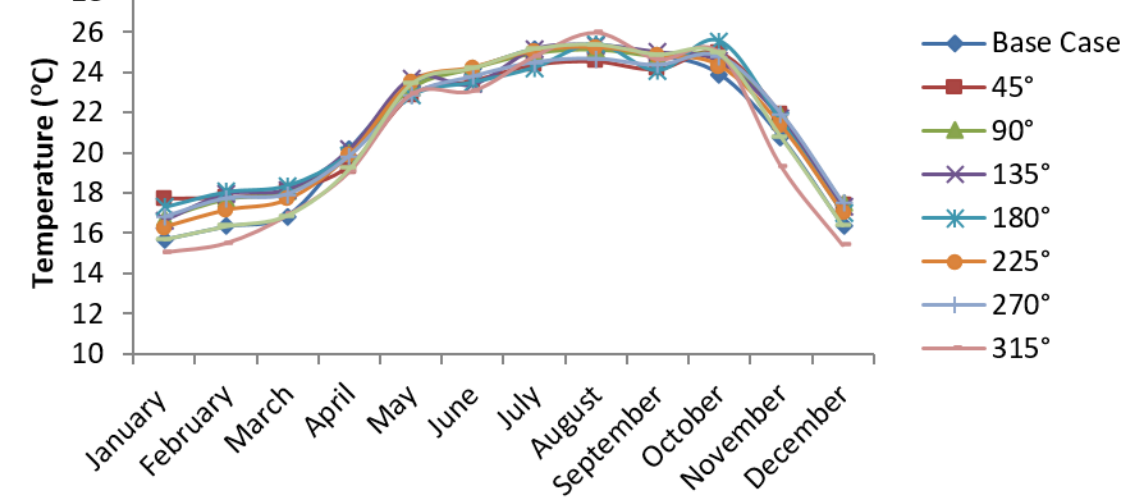
Figure 4. Temperature variations for different building orientations.